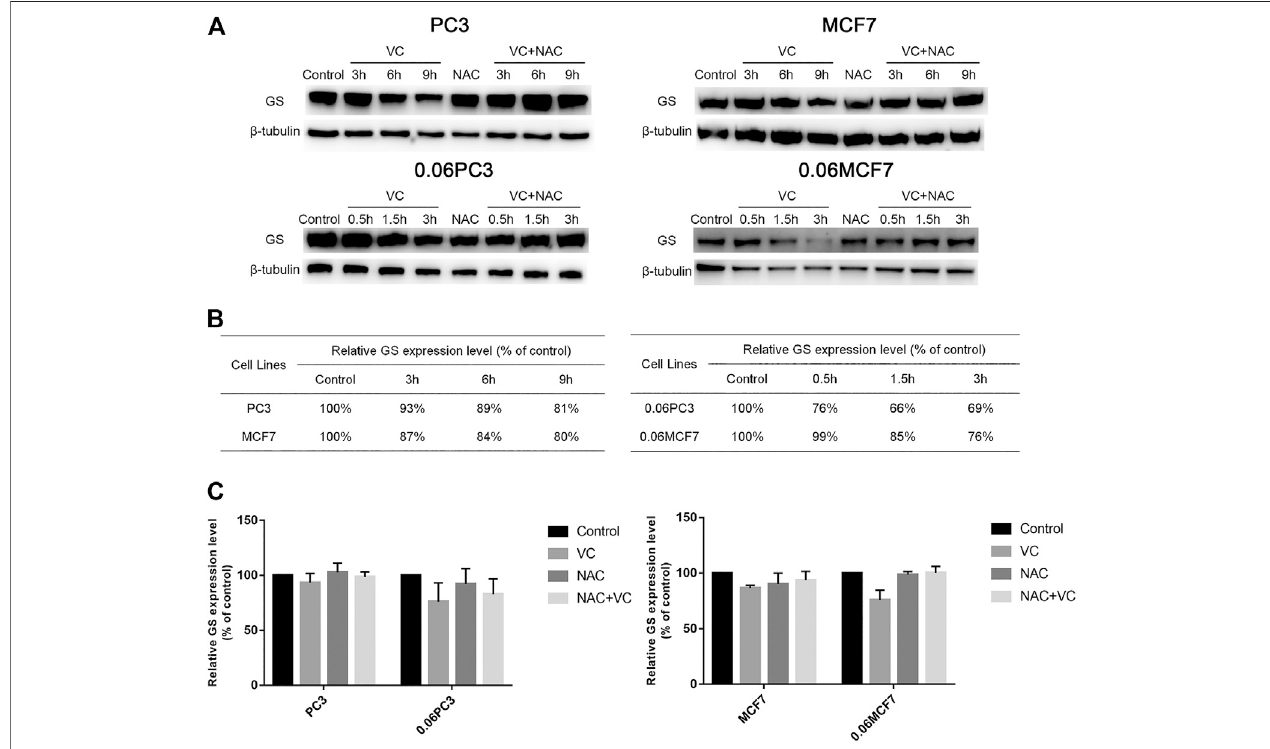
FIGURE 3 | Cancer cells overexpressing GS show augmented protein degradation under VC treatment, which is reversed by NAC. (A) GS protein in cancer cells (MCF7 、 PC3 、 0.06MCF7 、 0.06PC3) analyzed by Western blotting under treatment with VC(4 mM), NAC(5 mM), VC(4 mM) + NAC(5 mM) for indicated times. (B) The relativeGScontentsofcancercells(MCF7 、 0.06MCF7 、 PC3 、 0.06PC3)undertreatmentwithVC(4mM)forindicatedtimeswerecalculatedwith β -tubulinasaloading control. (C) The relative expression of GS in cancer cells (MCF7 、 0.06MCF7 、 PC3 、 0.06PC3) under treatment with VC(4 mM), NAC(5 mM), VC(4 mM) + NAC(5 mM) for 3 h. All data are presented as means ± SEM, n (cid:2) 3. VC, VitaminC; GS, glutaminesynthetase; NAC,